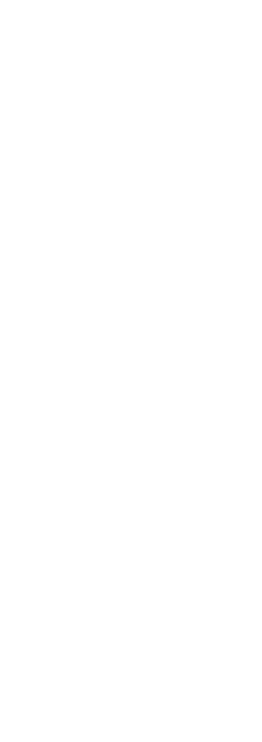
Figure 1. Patients flowchart. Seven cases were treated with both anti-platelet and anti-thrombotic drugs. FIT fecal immunochemical test, LDA low dose aspirin.